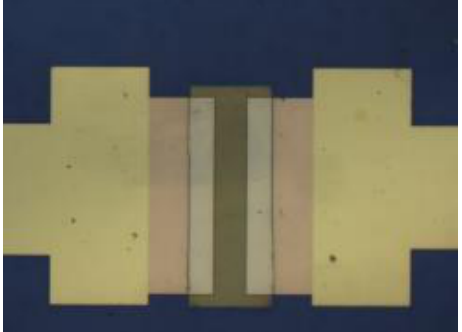
Figure 9. An optical photograph of the device after the fabrication of the dielectric layer.